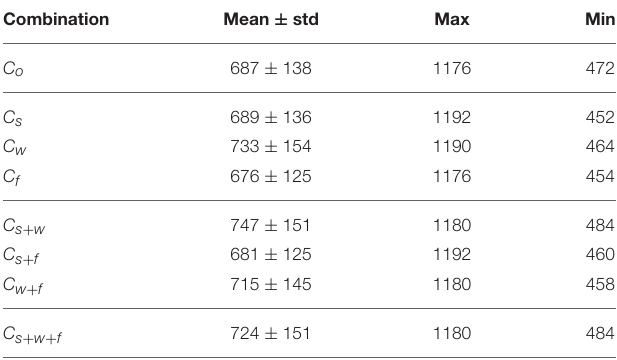
TABLE 2 | Summary of BRT (units of ms) for the eight experimental combinations.